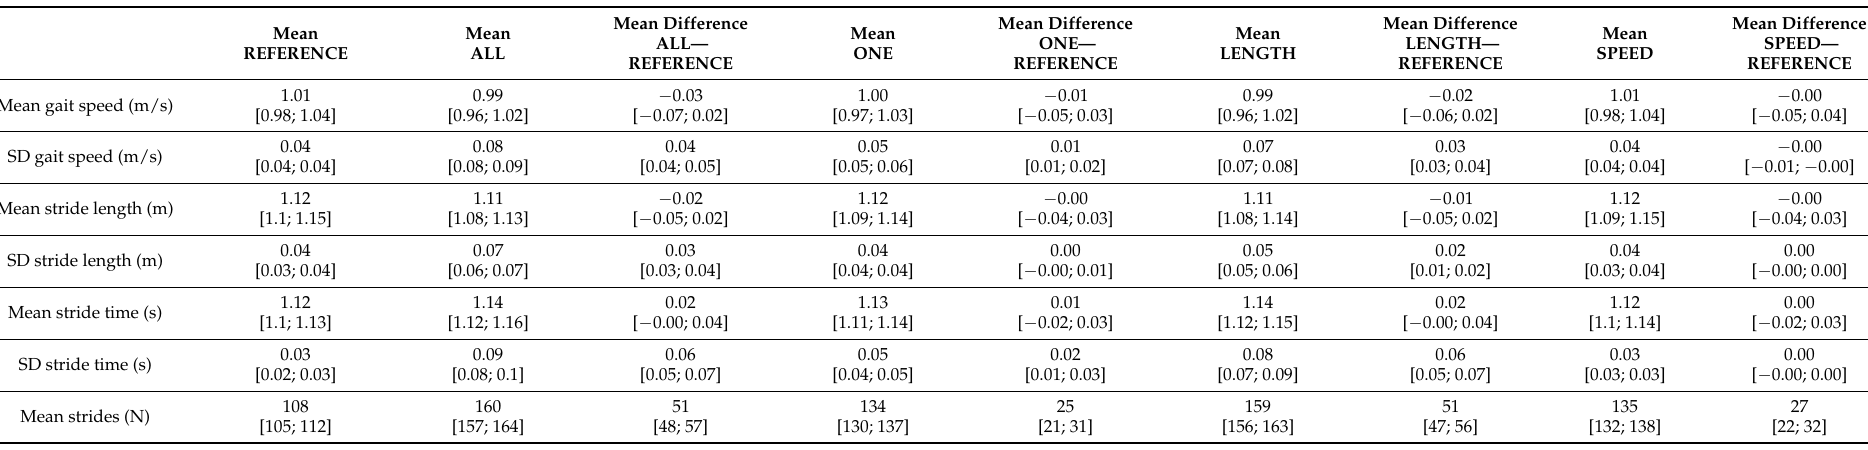
Table A1. Mean [99% CI] across subjects and the average within subject SD [99% CI] for gait speed, stride length, stride time and number of strides for each